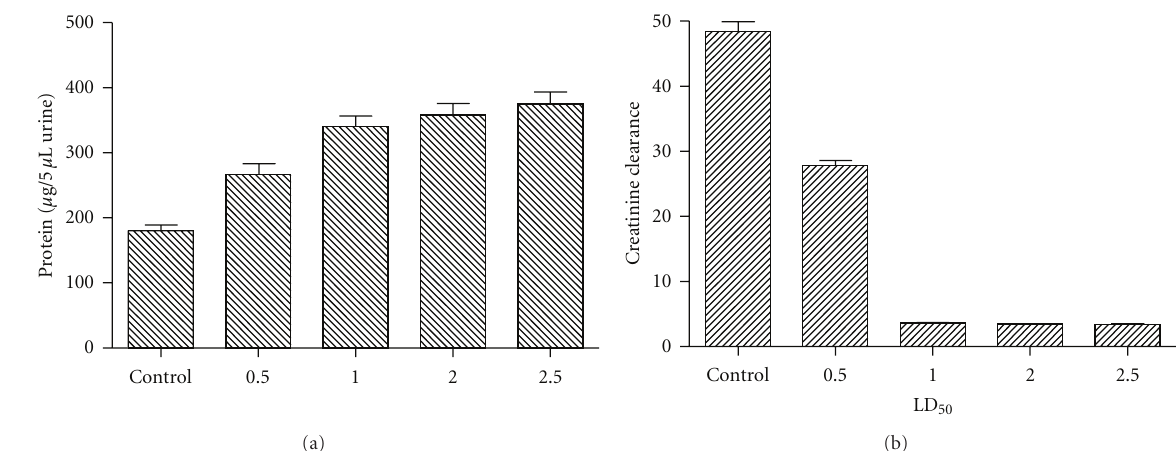
Figure 1: Protein present in urine and creatinine clearance. Groups of BALB/c female mice were injected i.p. with di ff erent amounts of Cdt for di ff erent times as above described. The presence of protein in urine was determined by measuring the albumin. Creatinine levels were detected in urine and serum from mice injected with di ff erent amounts of Cdt for 1h. The formula to determine creatinine clearance is described in Section 2. Each bar represents the mean value of samples from four experiments in di ff erent groups of five mice. Statistical di ff erences between the treatments were ( P > 0 . 01).